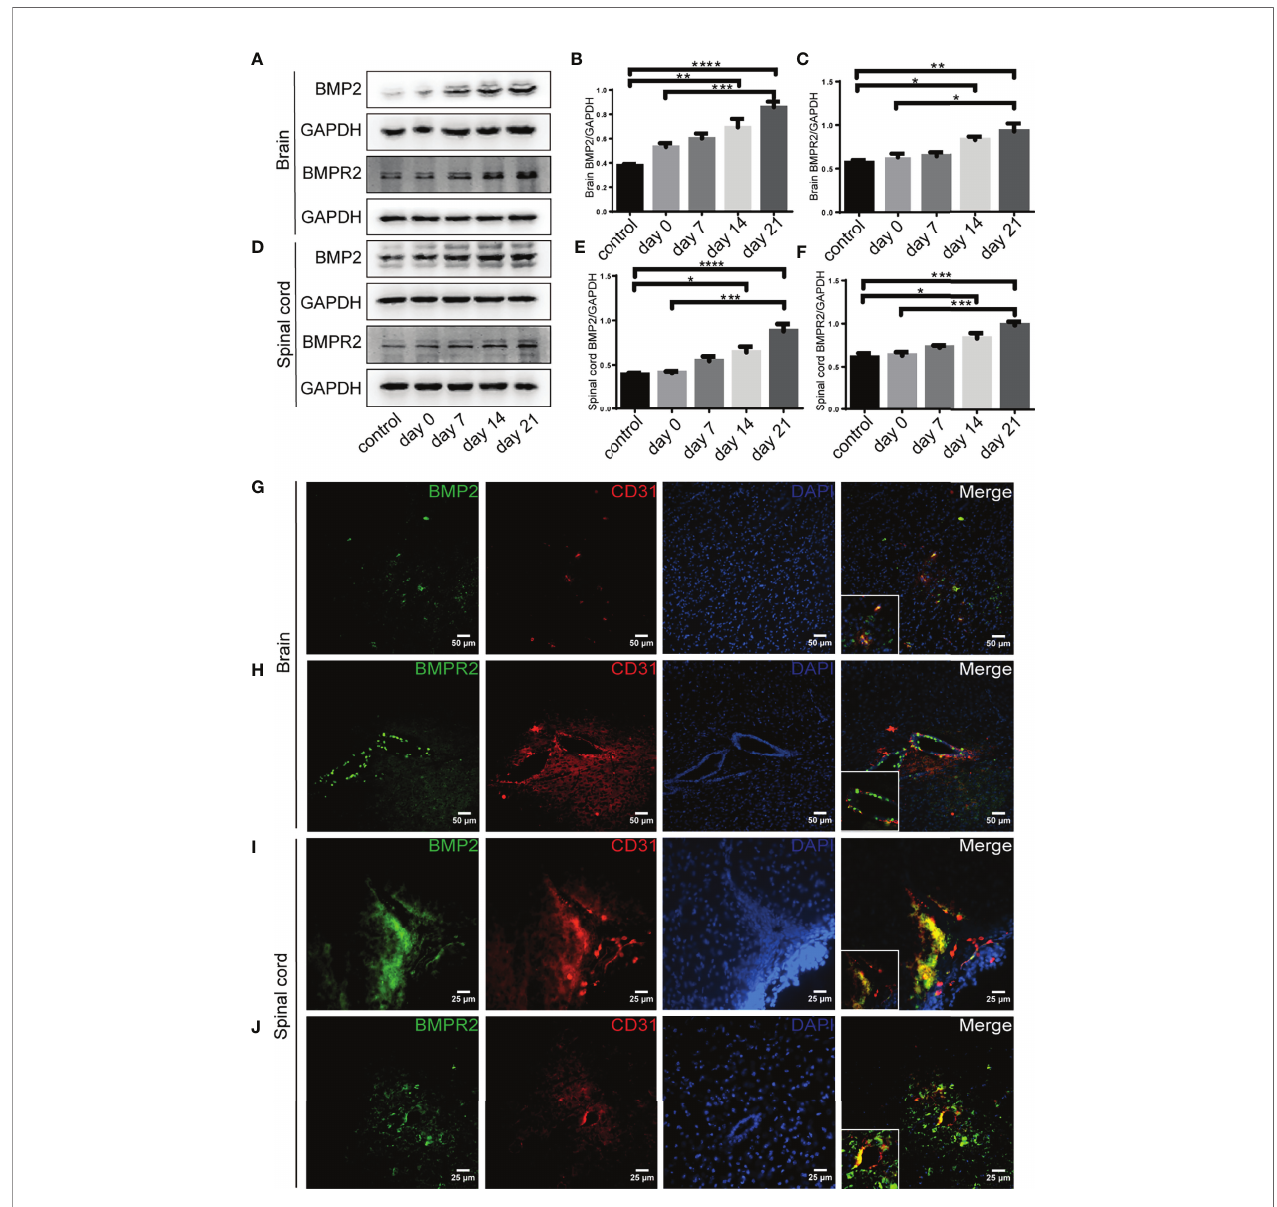
FIGURE 3 | BMP2 and BMPR II expression in EAE mice. (A – F) BMP2 and BMPR II in the brain and spinal cord were both upregulated in the 14- and 21-day group compared with the control group. BMP2 and BMPR II in both the brain and spinal cord were signi fi cantly higher in the 21-day than the 0-day groups ( n = 4,